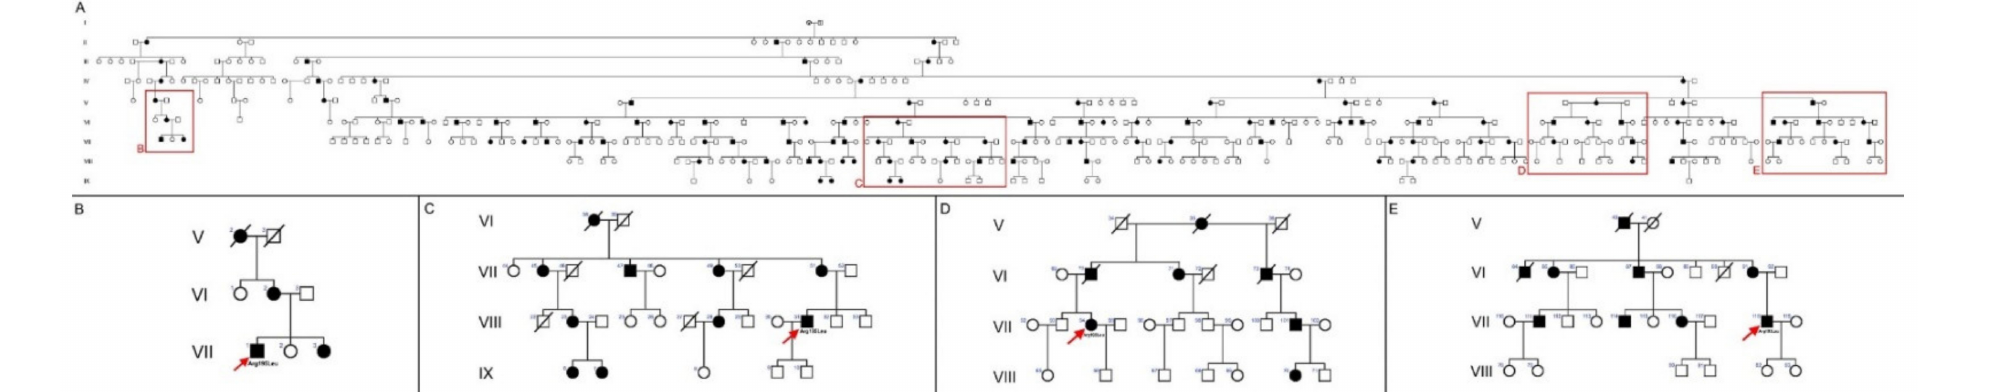
Figure 1. Entire pedigree of the Spanish family from 1750 to present. ( A ) Family members affected are indicated by black-filled shapes: 119 relatives were found to have retinal problems or blindness, of which 43.47% were women. A total of 60 of them are still alive and it is suspected that 60 more people in this family may also be affected. Most of these family members reside in the center of Cantabria, a province in Northern Spain. The 4 study family members within this pedigree are situated using red squares. ( B – E ) Pedigrees of the 4 study subjects. These subjects belong to different branches, though two of them are more closely related since they share a common descendant in the IV generation. A total of 3 patients (VII.1, VII.94, and VII.118) belong to the VII generation and the other (VIII.31) to the VIII generation. The autosomal dominant inheritance pattern can be clearly